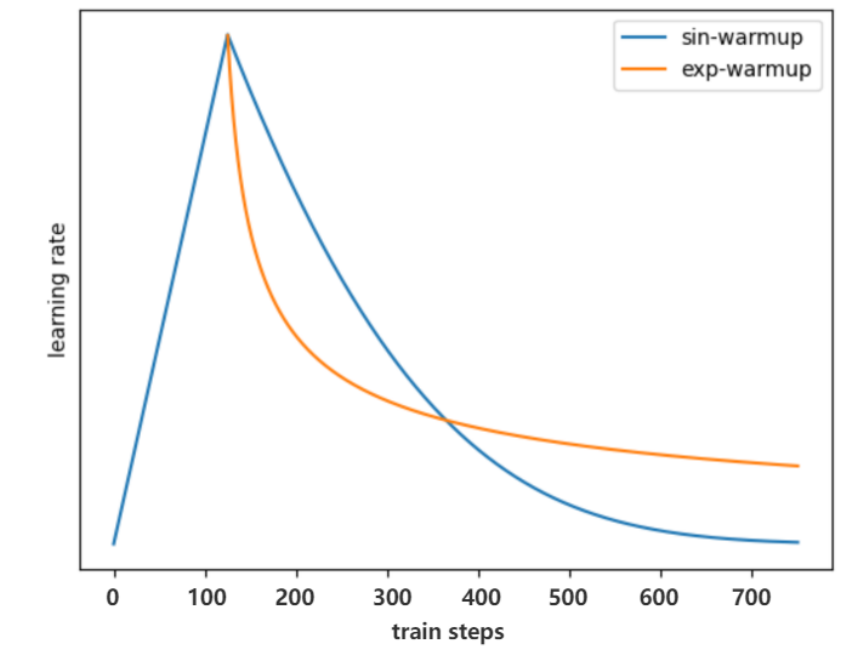
Figure 7. Warmup learning rate schedule.